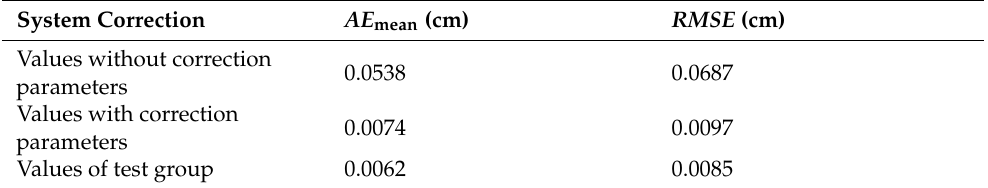
Figure 14. Measurement value comparison before and after parameter correction. Table 1. Comparison between measuring systems optimized by two objective parameters.